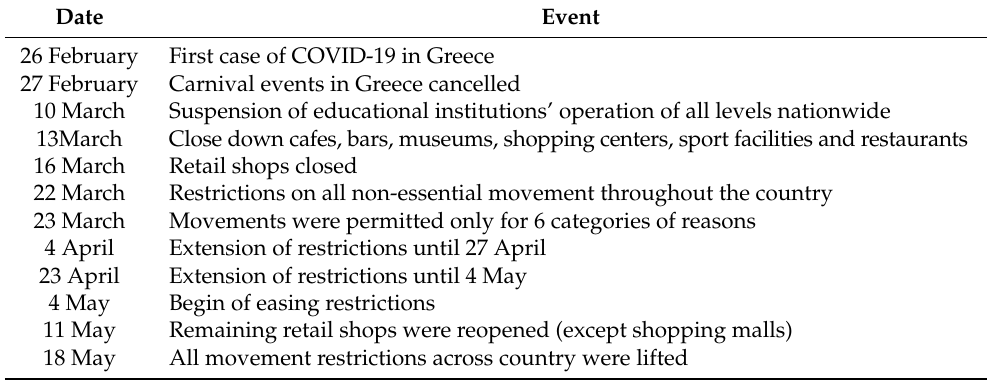
Table 3. Timeline and milestones of COVID-19 pandemic in Greece for the period February 2020–May